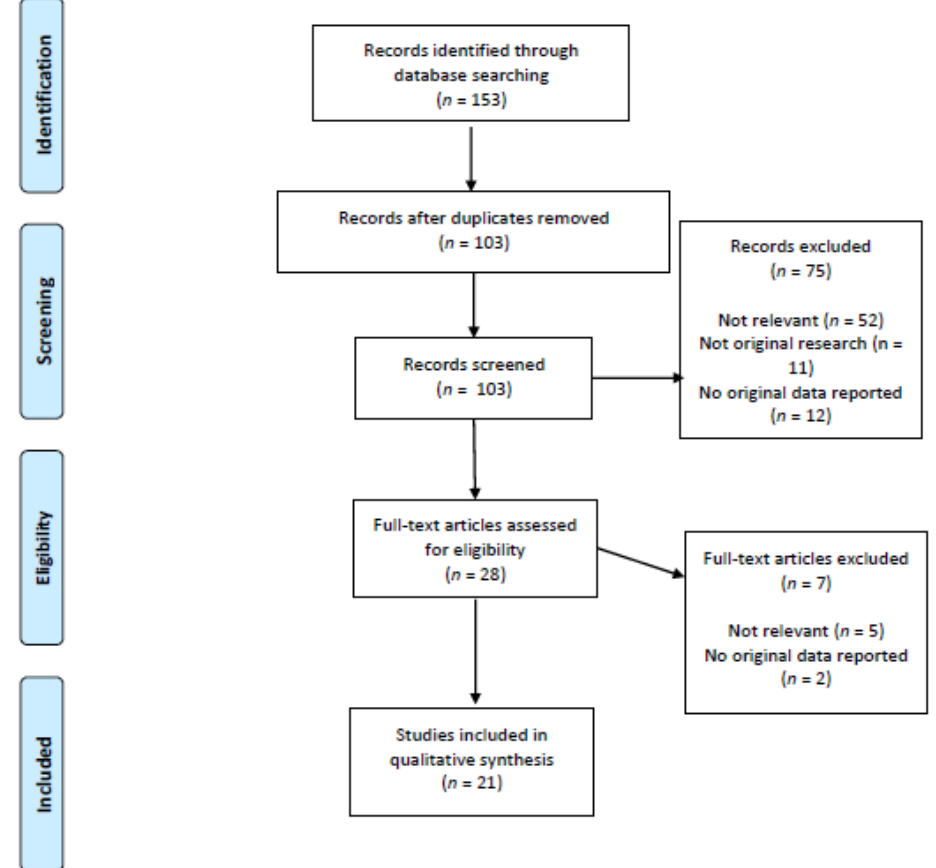
Figure 1. PRISMA